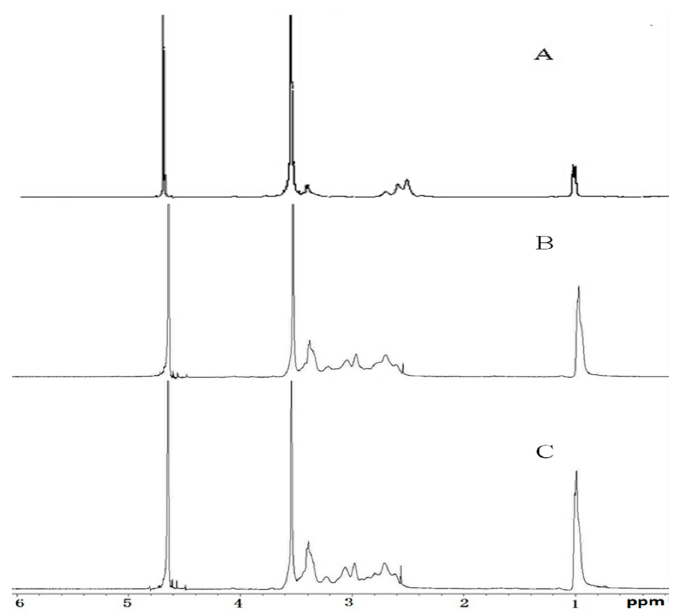
Figure 1. 1 H-NMR spectra of ( A ) P123-PEI; ( B ) P123-PEI-R4; and ( C ) P123-PEI-R11 in deuterium oxide at room temperature.